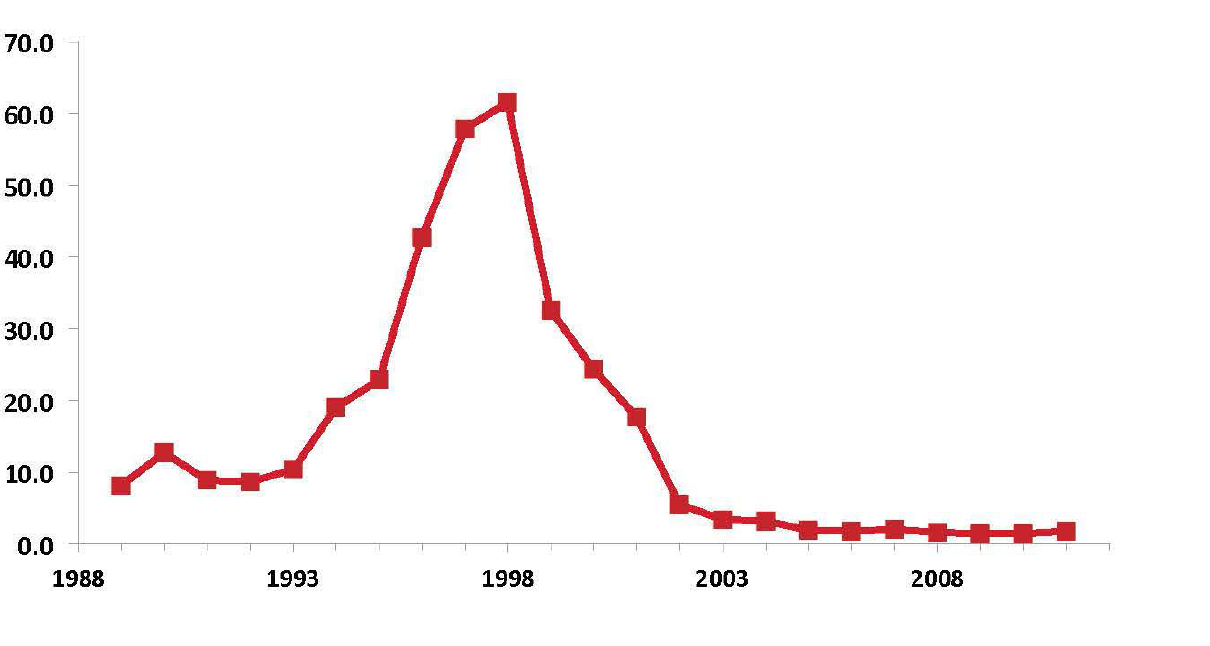
Figure 4. Ratio of Mexico to China in U.S. Imports of TV Receivers (SITC